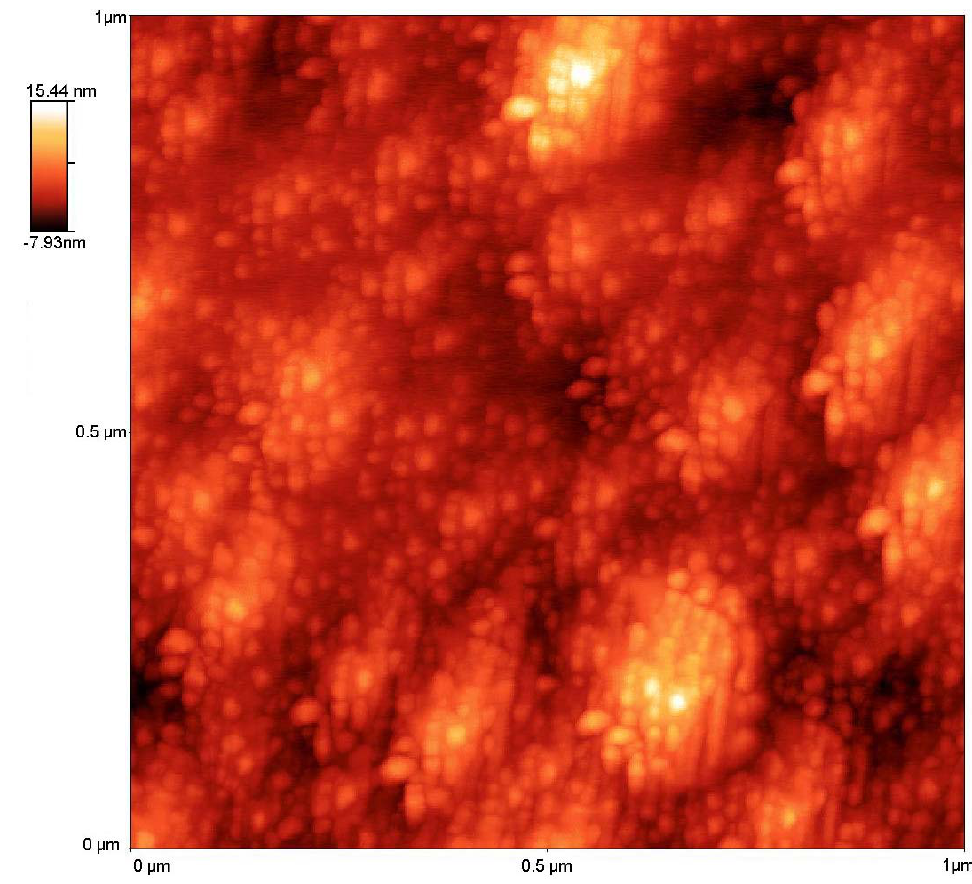
Figure 1. AFM image of the SiO